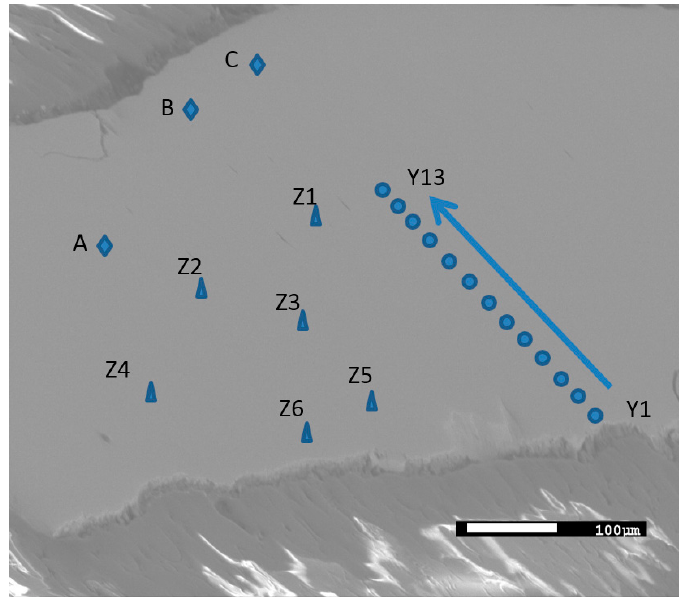
Figure 2. SEM-BEI of the 8-h annealed sample. Structures of spots Z1 to Z6 and A to C were studied by EBSD. Compositions of spots Y1 to Y13 were measured by EDS.